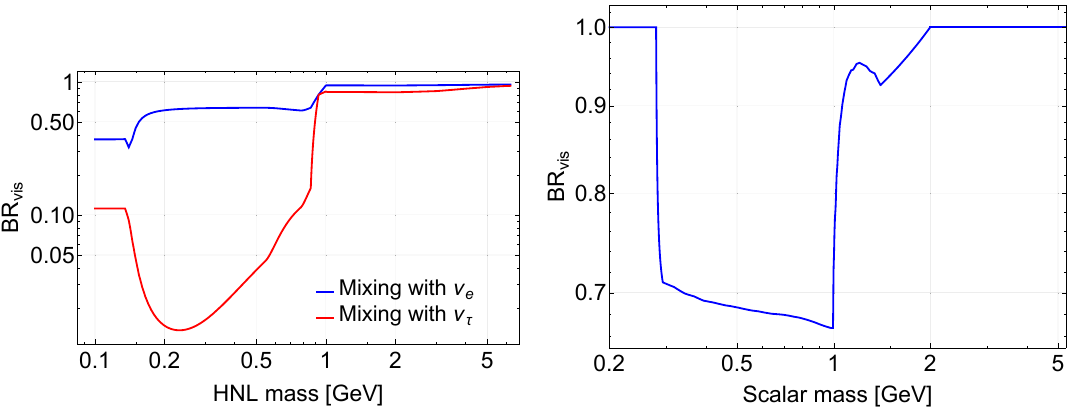
Figure 6 . The branching ratio of decays of the HNLs (left) and the scalars (right) in visible states. The drop of the branching ratio for the HNLs mixing with ν in the domain of HNL masses (cid:31) 1 GeV τ is caused by the dominant invisible decay N π 0 ν τ , while for the scalars of the same masses — → by the decay S π 0 π 0 . → Exp.